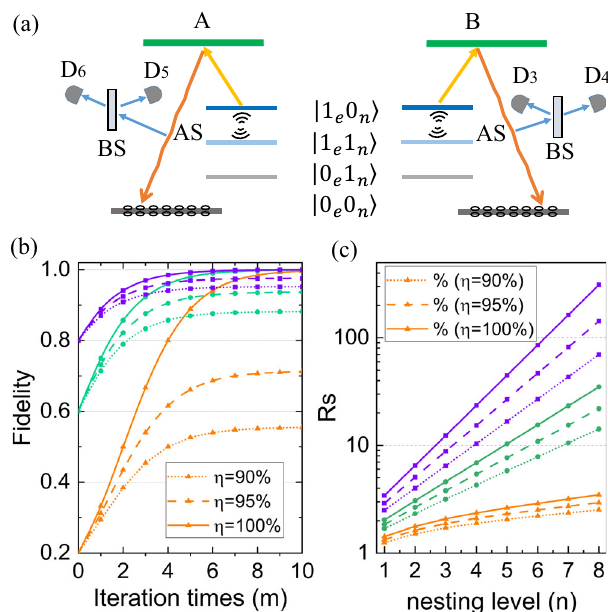
Fig. 2 The entanglement distillation proposal and its enhancement on entanglement fi delity and rate. a The energy-level diagram and the entanglement distillation proposal. A and B represent two distant communication nodes. The subscript e and n denotes the electron and nuclear degrees of freedom, respectively. Anti-Stokes, AS; beam splitter, BS; Detector, D. b The fi delity after entanglement distillation as a function of the iteration times with the initial fi delity of 0.2 (triangle symbol and yellow line), 0.6 (dot symbol and green line) and 0.8 (square symbol and purple line), respectively. c The speedup coef fi cient R s as a function of the nesting levels by increasing the excitation rate p c and utilizing entanglement distillation after the last level ’ s entanglement connection process. p c = 10 − 3 (triangle symbol and yellow line), 10 − 4 (dot symbol and green line), 10 − 5 (square symbol and purple line). The dot, dash, solid line represents the total ef fi ciency η = 90%, 95%, 100%,